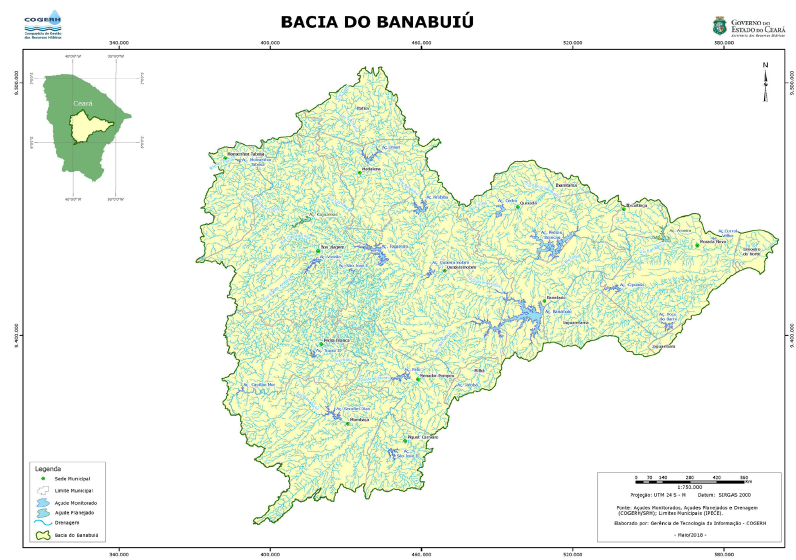
Figure 1. Location Map of the Banabuiú Basin. Source: Adapted Cogerh,